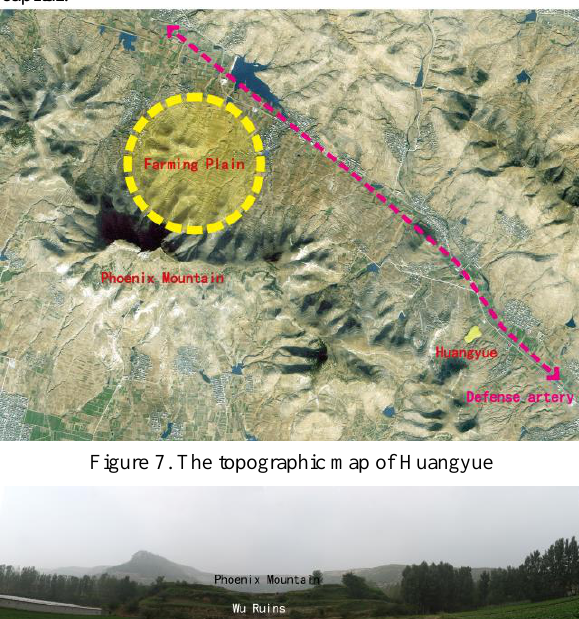
Figure 8. The relationship between Huangyue and Phoenix Mountain